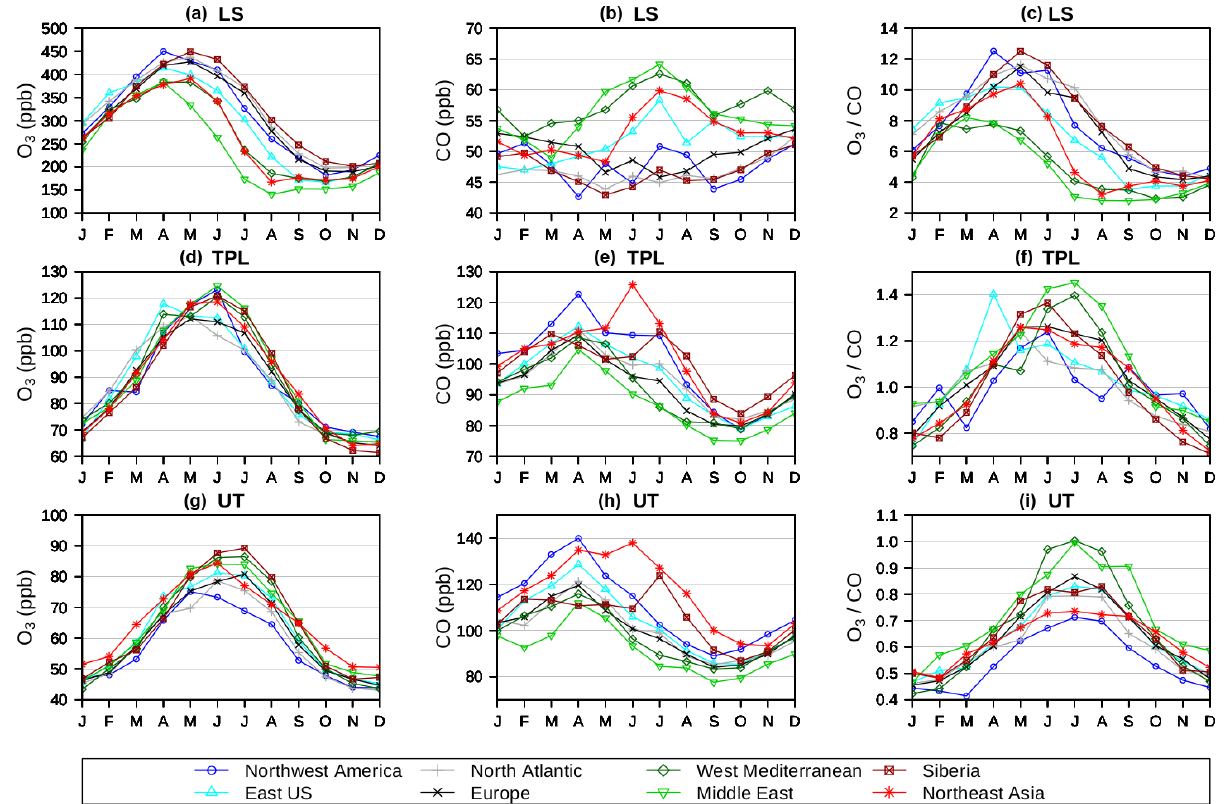
Figure 6. Mean seasonal cycles of O 3 , CO, and O 3 / CO (from left to right) in the upper troposphere, tropopause layer, and lower stratosphere (from bottom to